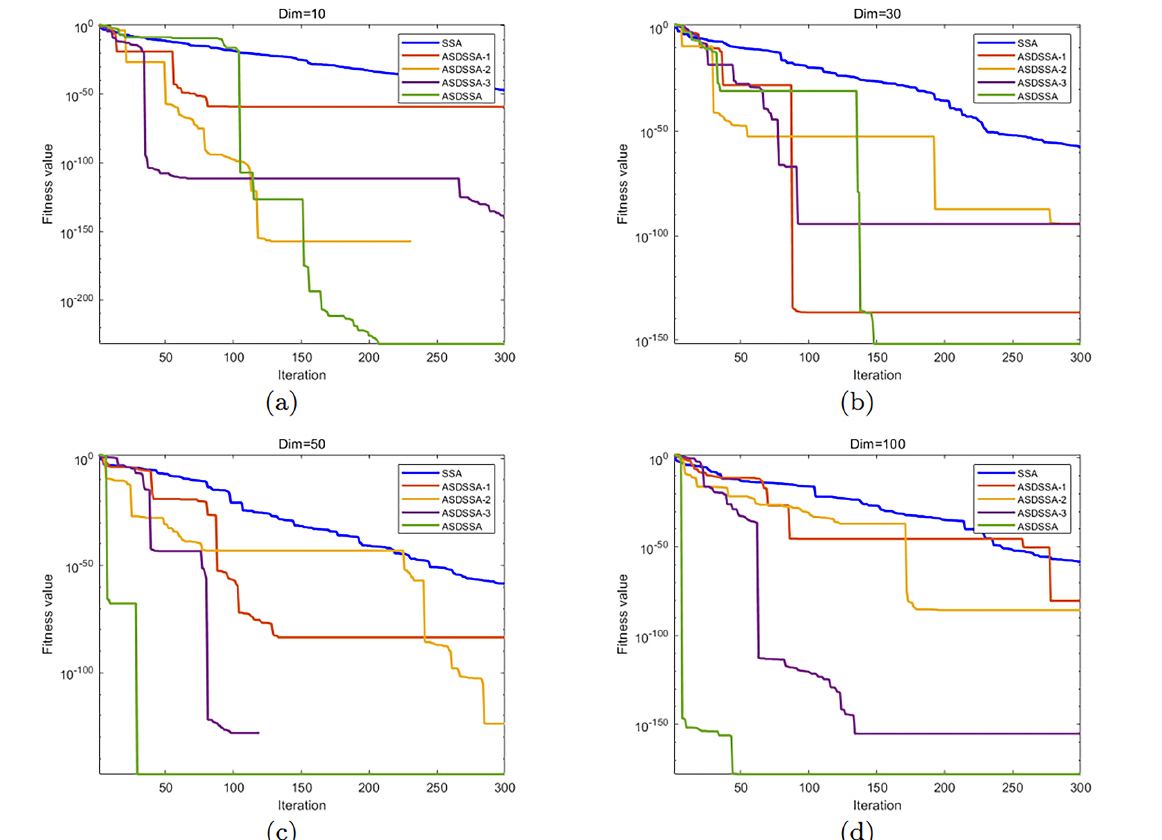
Figure 4. Comparison of the effectiveness of different